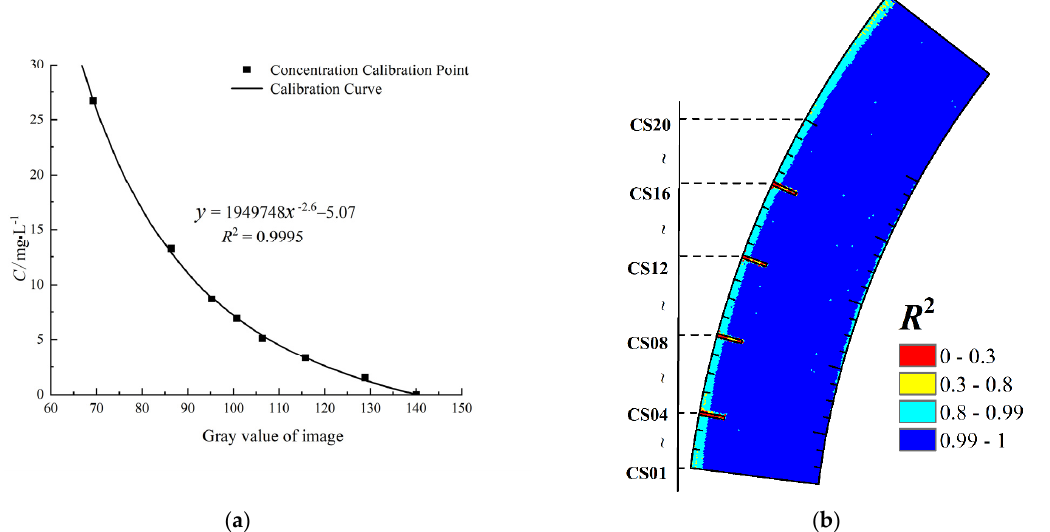
Figure 2. Fitting of calibration function in experimental area. ( a ) Calibration curve fitting of a pixel. ( b ) The R 2 of calibration function.